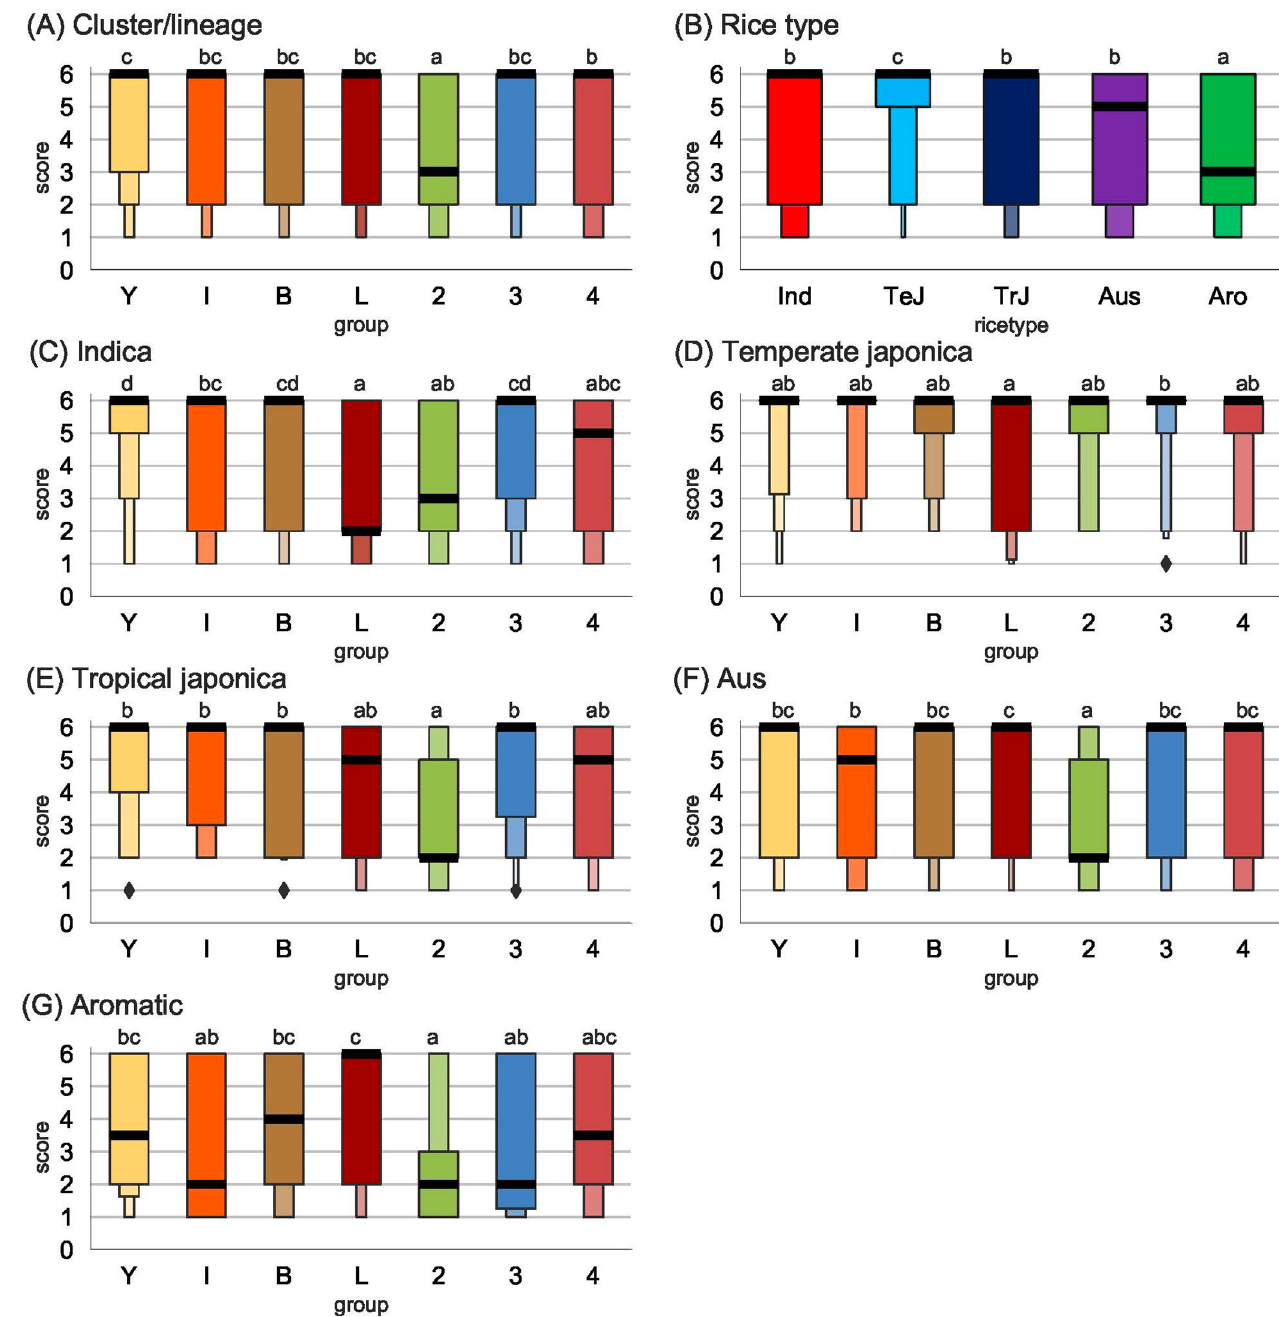
Fig 4. Compatibility between 70 P . oryzae isolates and 45 rice varieties, representing five types of rice. Compatibility was measured as symptom scores [54,55] estimated using pathogenicity tests in controlled conditions. A: Symptom scores as a function of the lineage of origin of isolates, or cluster of origin for isolates from lineage 1; B: Symptom scores as a function of the type of rice; C-G: Symptom scores as a function of the lineage of origin of isolates, for each type of rice. Abbreviations: Y, Yule ; I, International ; B, Baoshan ; L, Laos ; 2, lineage 2; 3, lineage 3; 4, lineage 4; Ind, indica; TeJ, temperate japonica; TrJ, tropical japonica; Aro, aromatic. Shared small capitals indicate non-significant differences (pairwise comparisons after computing least-square means, with Tukey adjustment). All interactions between rice varieties and P . oryzae isolates were assessed in three independent experiments, and the median of the three symptom scores was used in calculations. Boxen plots were drawn using function boxenplot() with P YTHON package SEABORN 0.11.1. Starting with the median as centerline, each successive level (i.e., each successive box) outward contains half of the remaining data. Number of boxes was controlled using option k_depth = ‘trustworthy’. Black horizontal lines represent the